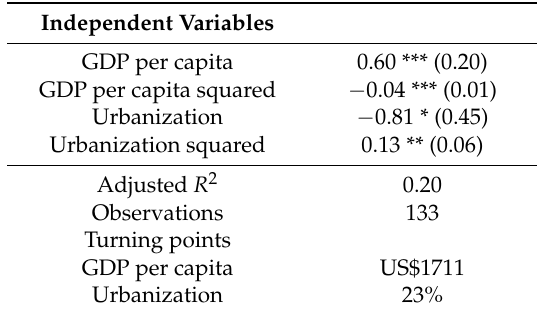
Table 2. Kuznets-style cross-sectional regression. GINI index is dependent